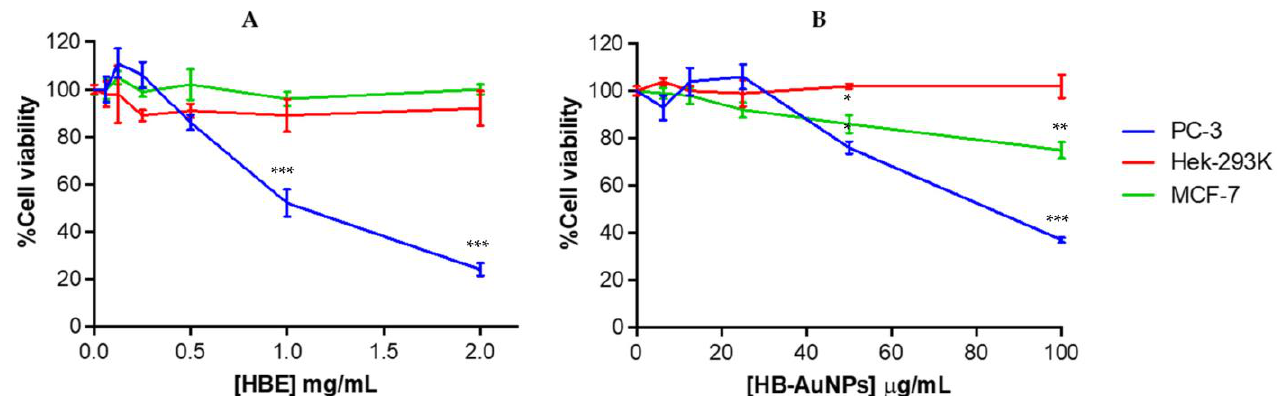
Figure 7. Cytotoxicity of HBE ( A ) and HB-AuNPs ( B ) in PC-3, KMST-6, HEK-293, and MCF-7 cells after 24 h. p ≤ 0.05 was considered as statistical significant for untreated vs. treated samples, * p ≤ 0.05, ** p ≤ 0.01 and *** p ≤ 0.001.